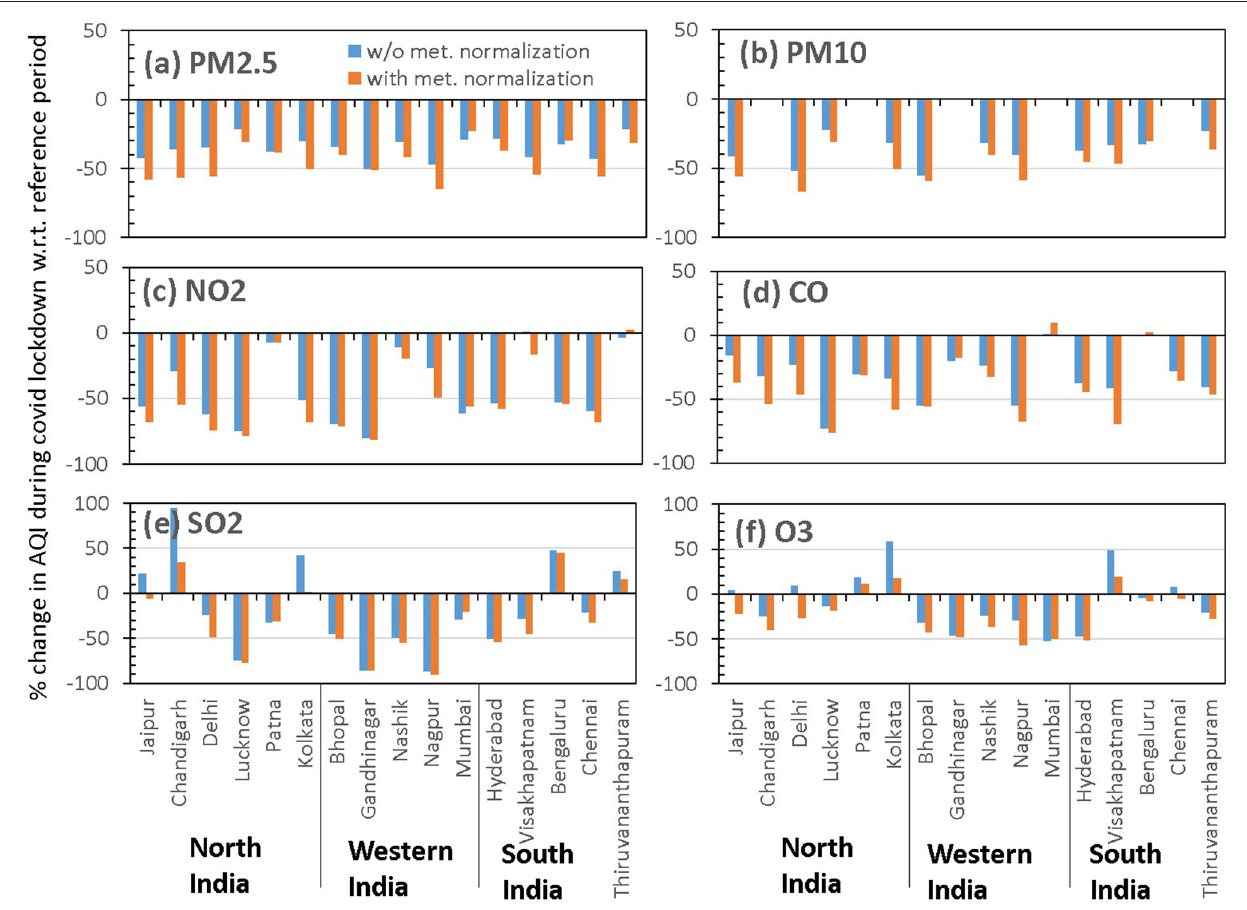
FIGURE 2 | City-specific percent change of key pollutants (with and without meteorology normalization) during complete lockdown with respect to the reference